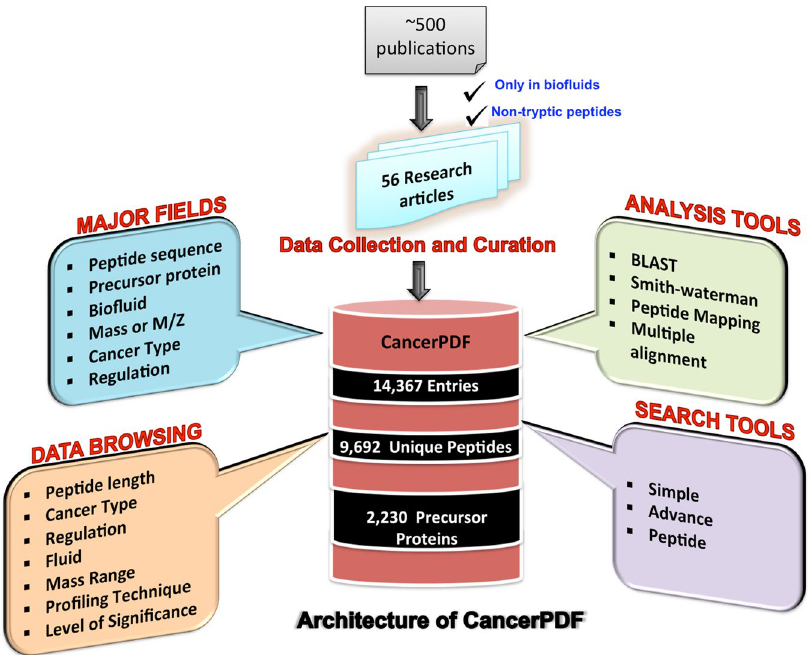
Figure 1. Architecture of CancerPDF